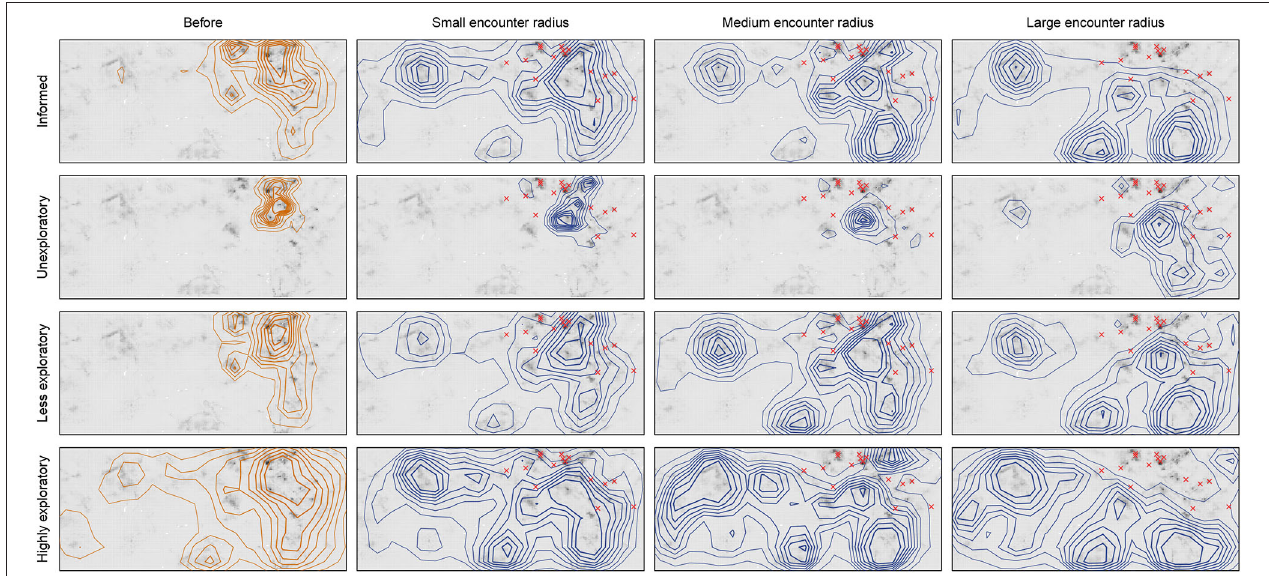
FIGURE 2 | Space use by foragers quantified by kernel utilization distributions comparing before predators (orange, column 1) to after predators (blue, columns 2–4). Rows indicate memory state and columns indicate predator encounter radius. Contour lines show 20–90% utilization. Predator center point locations shown with red x ’s (see Figure 1 for radii). Intrinsic habitat quality shown in grayscale.